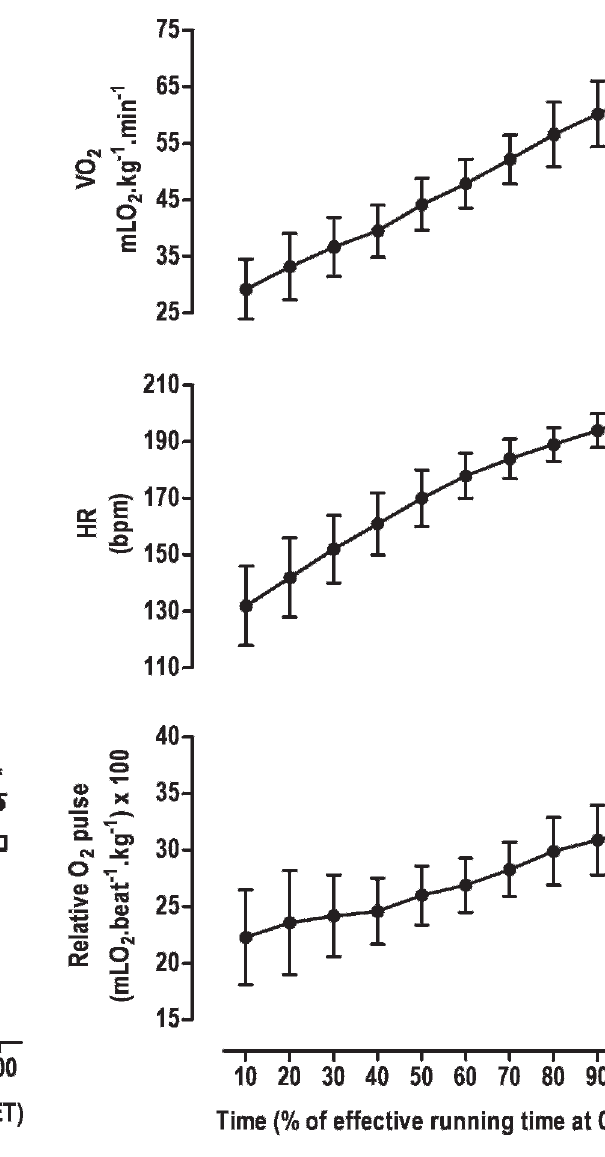
Figure 2 - Heart rate, oxygen consumption and oxygen pulse curves for soccer players during maximal cardiopulmonary exercise testing (n = 180). Error bars represent the standard deviation of